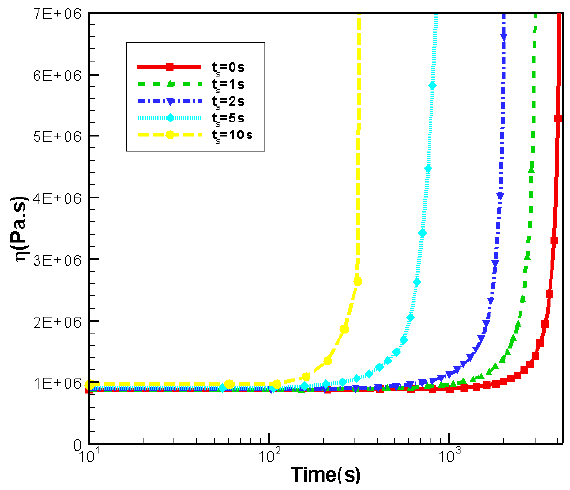
Figure 10. Evolution of viscosity with different shear time.